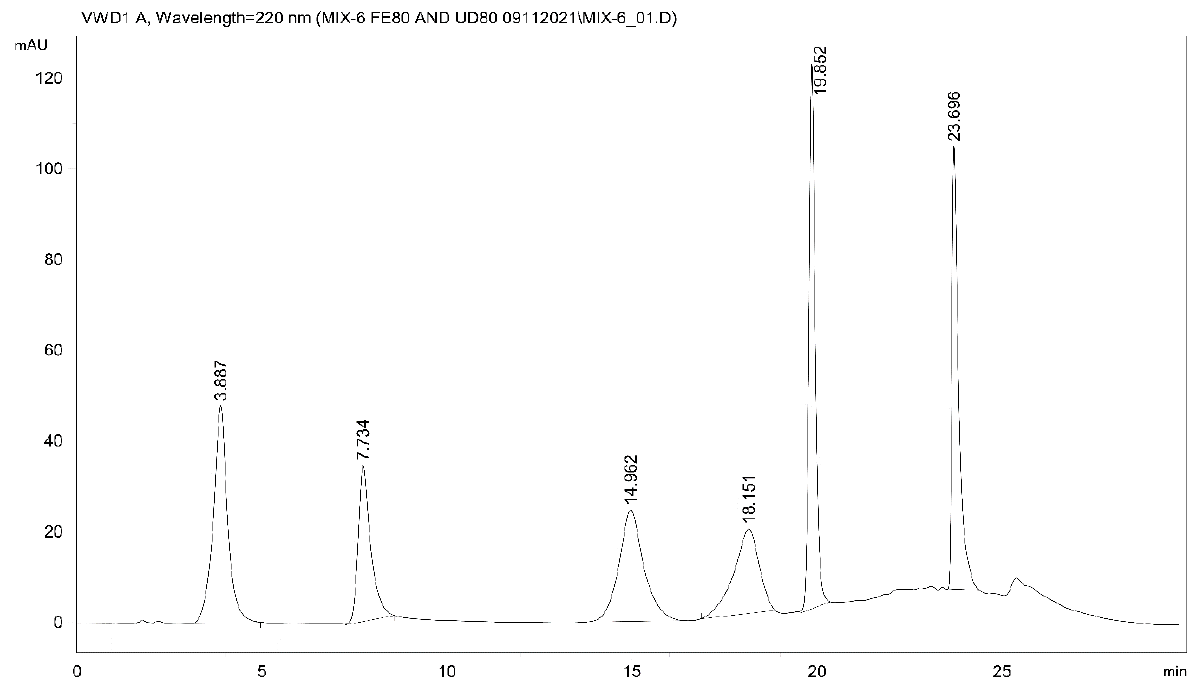
Figure 2 . HPLC-UV chromatogram (Method I) of IBP and oxidative metabolites of IBP in ACN (30 μg mL − 1 each). The retention times (t R ) of the separated standards are as follows: 3-OH-IBP ( 4 ) (3.89 min), SA (internal standard) (7.73 min), 2-OH-IBP ( 3 ) (14.96 min), HOOC-IBP ( 5 ) (18.15 min), 1-OH-IBP ( 2 ) (19.85 min), and IBP ( 1 ) (23.70 min).